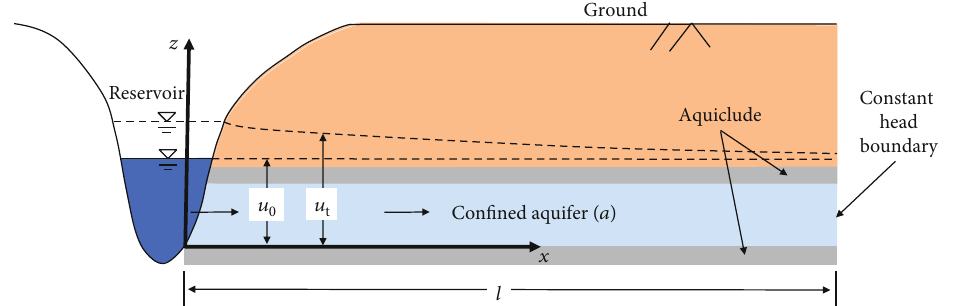
Figure 1: Schematic diagram of the hydraulic response of a con fi ned aquifer.